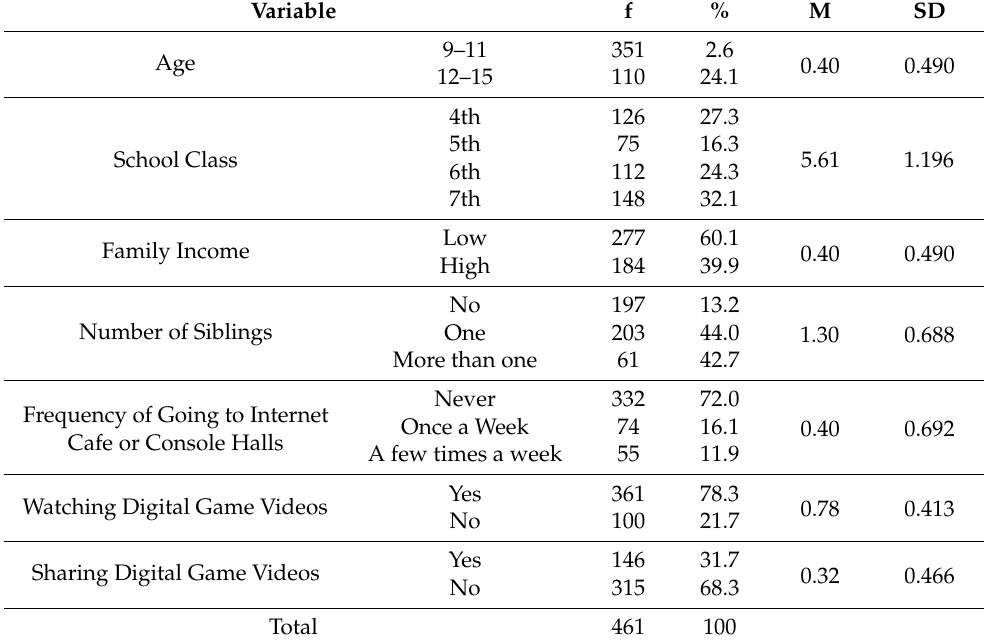
Table 1. Descriptive